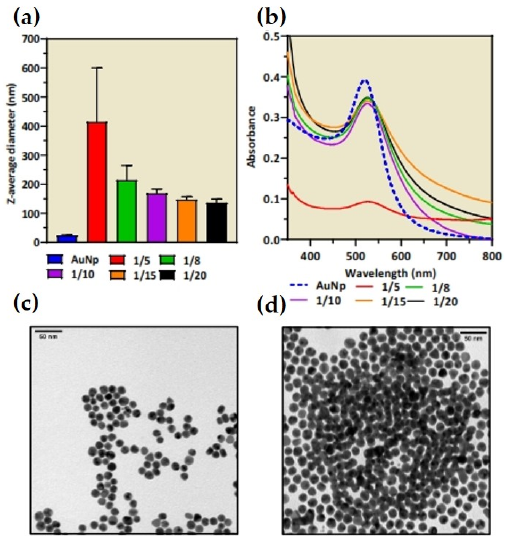
Figure 1. ( a ) Z-average diameter of gold nanoparticles and Au/dynamer conjugates determined by DLS ( n = 3); ( b ) UV-Visible spectra of gold nanoparticles and Au- DCF. TEM images of ( c ) citrate- stabilized gold nanoparticles at 0.105 mM and ( d ) of Au-DCF conjugates at 1/20 Au/DCF molar ratio.